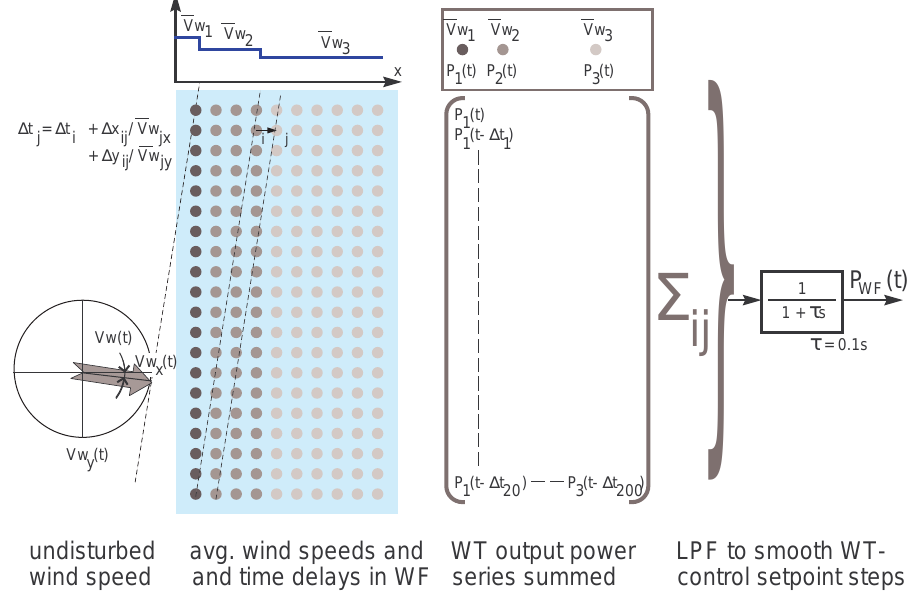
Figure 3. Synthesized wind farm output